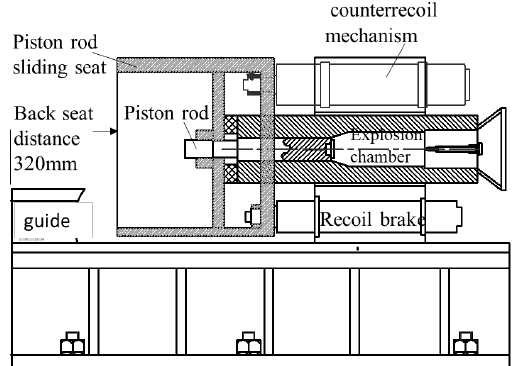
Fig. 1. Sketch of the working